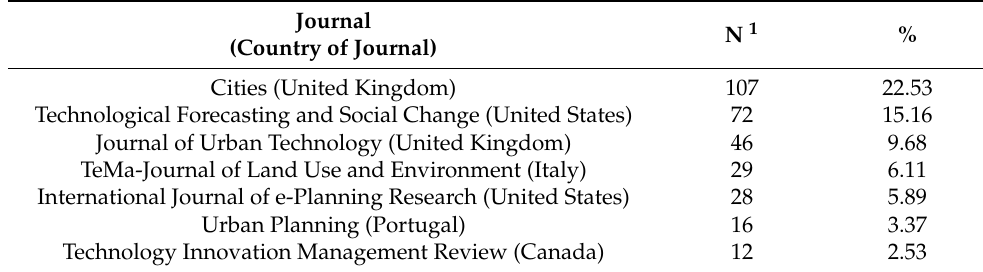
Table 2. Number of documents per journal.